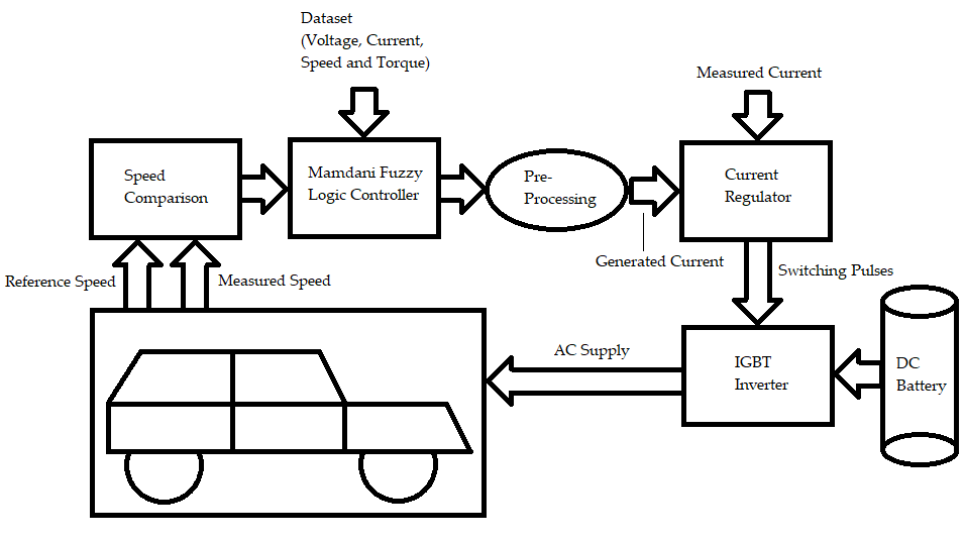
Figure 7. Block diagram of closed-loop MFLC speed control